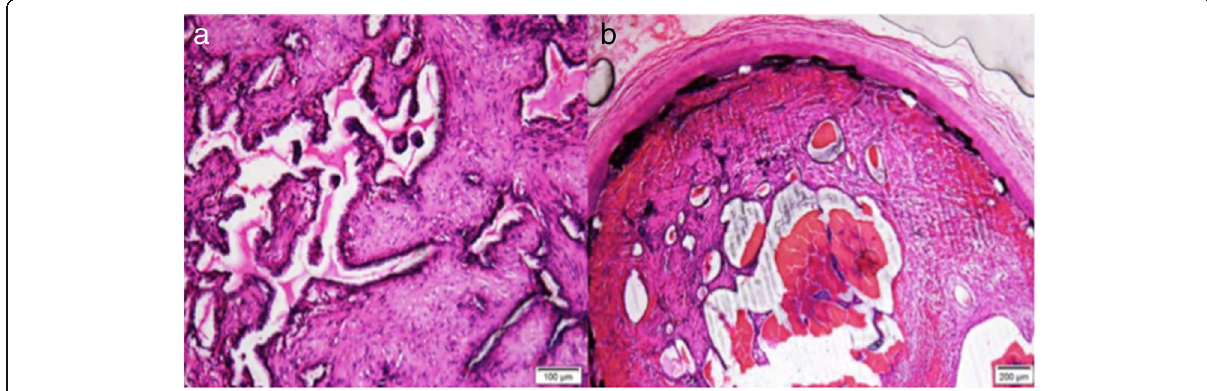
Fig. 8 Sections from explanted HPC-2-coated device from subject number 2 show luminal occlusion with re-canalised organising (mid-segment) to organised (proximal and distal sections) thrombus ( a ). Chronic inflammatory cells infiltration around the mesh wires are visible ( b ). Haematoxylin and eosin stain, × 100